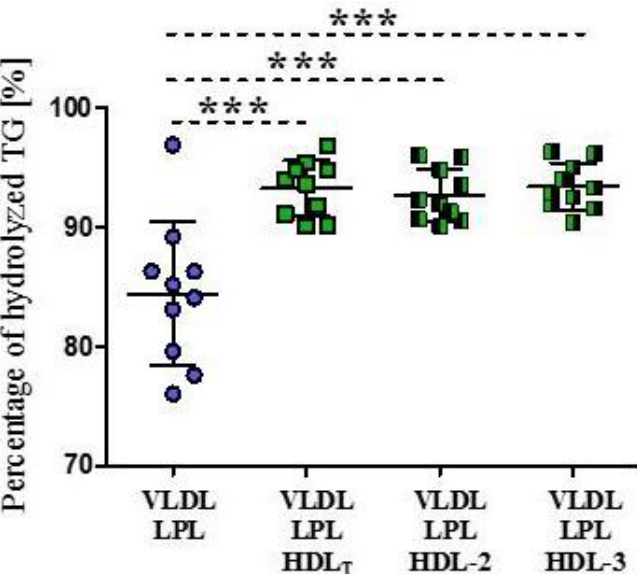
Figure 1. Percentage of hydrolyzed TG during LPL-mediated VLDL lipolysis in the absence and presence of HDL T and HDL subpopulations: HDL-2 and HDL-3. Data are presented as mean ± SD, n = 10, *** p < 0.001. Data were analyzed by Repeated Measures ANOVA with Tukey post hoc. 3.2. Impact of HDL Subpopulations on the Release of Surface Lipids from VLDL during Lipolysis LPL-mediated lipolysis in the absence of HDL led to an average decrease in FC and PL content in VLDL of 6 ± 5.6% and 21 ± 11%, respectively (Figure 2). The degree of surface lipid released from VLDL varied between individuals, ranging from 0.2% to 17% for FC and from 10% to 44% for PL.